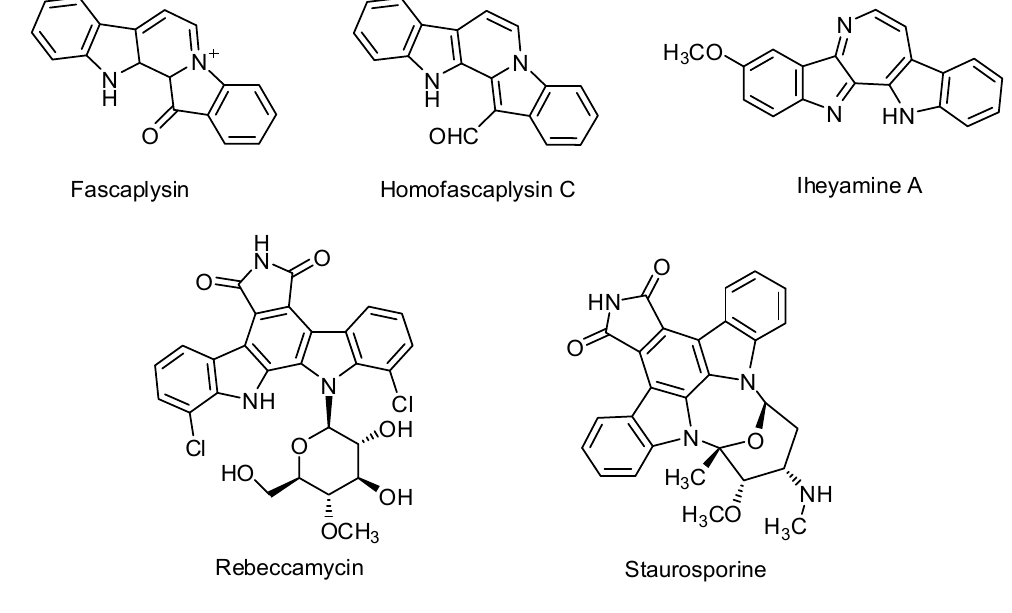
Figure 1. Some active poly cyclic natural compounds.